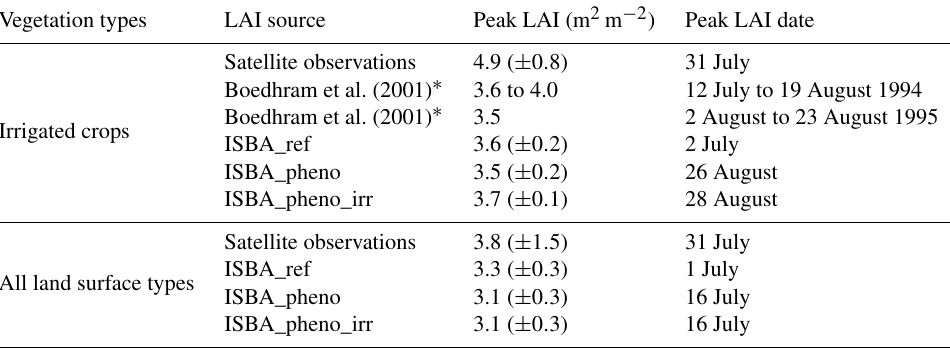
Table 4. Observed and simulated mean LAI peak characteristics over Nebraska for the 1999–2018 time period for irrigated crops (see Fig. 4) and all land surface types (see Fig.